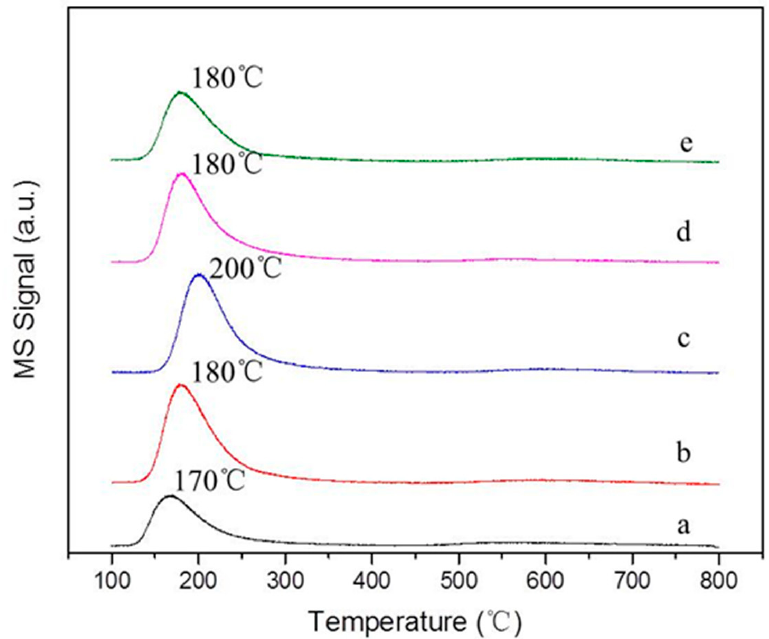
Figure 8. NH 3 -TPD profiles of different catalysts (a) 0.2% Pd/SiO 2 ; (b) 0.2% Pd-AlPO-5/SiO 2 ; (c) 0.2% Pd-AlPO-8/SiO 2 ; (d) 0.2% Pd-AlPO-11/SiO 2 ; (e) 0.2% Pd-AlPO-31/SiO 2